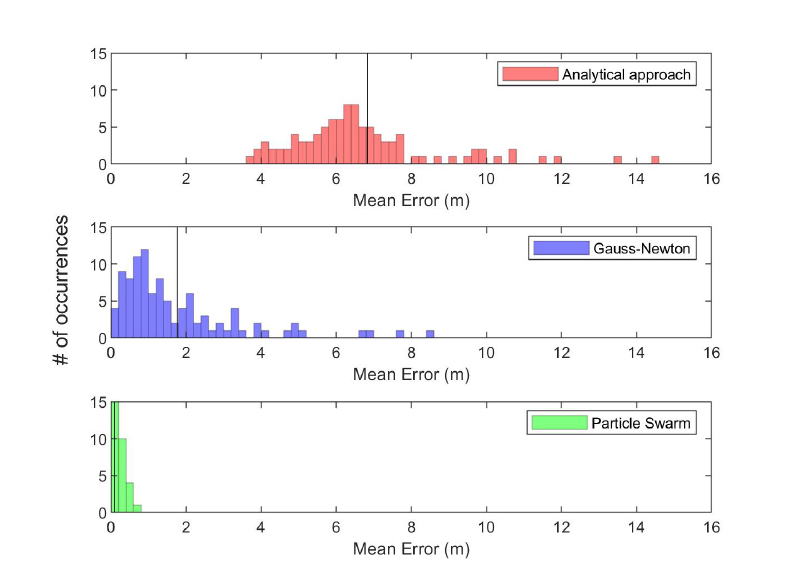
Figure 4. Histograms of mean multilateration error of around 15,000 multilateration process carried out in 100 walkers (nodes); the vertical line in each histogram represents the mean error of the entire